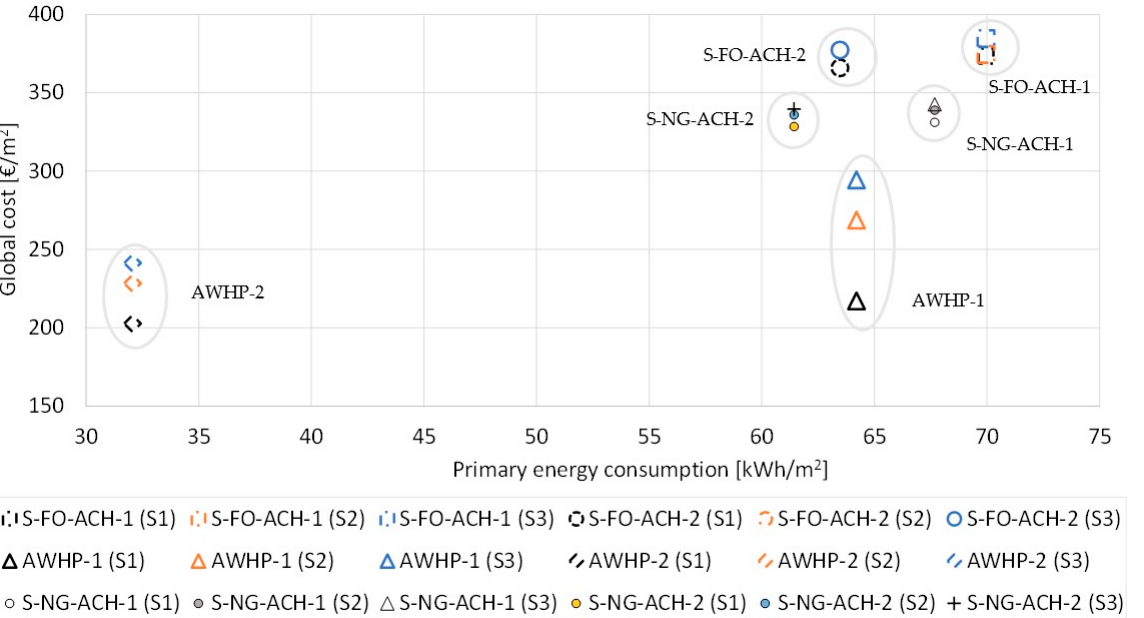
Figure 9. Results of global cost and primary energy consumption from simulations for HVAC systems in three scenarios of energy prices (S1, S2, S3).